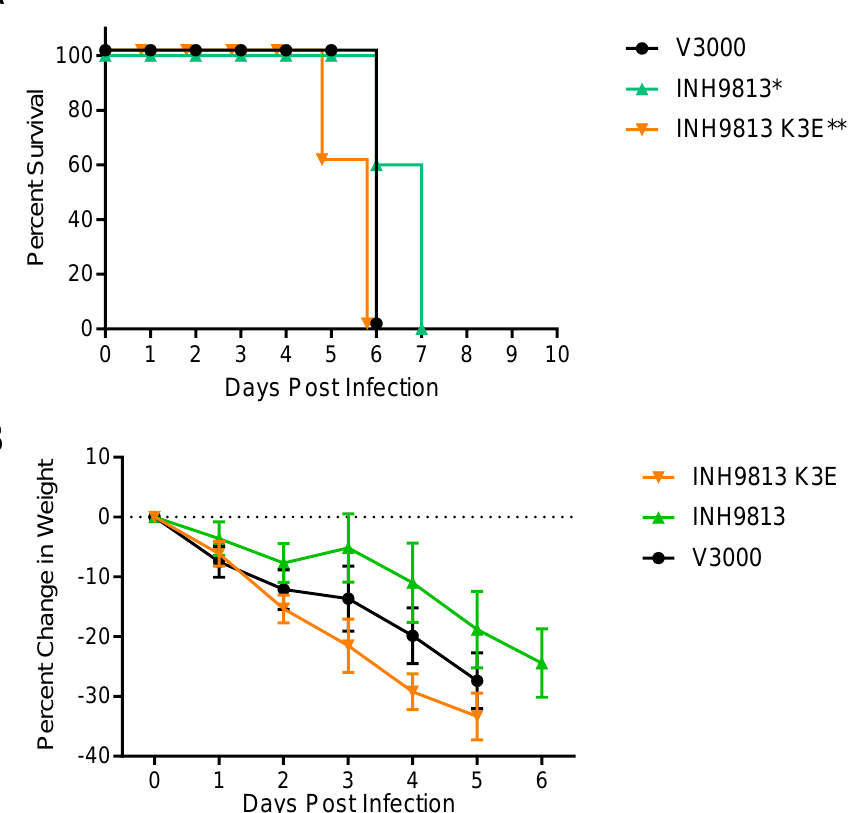
Figure 6. Survival curves ( A ) and weight loss ( B ) for 4–week–old CD–1 mice infected subcutaneously with 1000 PFU of each indicated virus. Experiments included 5 or 10 animals per group and were performed at least twice with similar results. Error bars are standard deviations. * = Survival V3000 vs. INH9813 p < 0.001, ** = Survival INH9813 vs. INH9813 K3E p < 0.001. With EEEV, sc. infection survival times for EEEV V105 and FL93–939 were not signifi- cantly different ( p > 0.916) (Figure 8A). However, V105 infections in this experiment series did yield one survivor (Figure 8A), which is also occasionally seen with FL93–939. Aerosol LD 50 values were also not significantly higher for FL93–939 vs. V105 ( p > 0.05) (Figure 9), although calculated values were lower for V105. With WEEV, we compared the McMillan clone with either Fleming or this virus with lysine changed to glutamic acid at E2 84 or this mutation and valine changed to methionine at E2 83 (K84D, V83M) (Figure 10). After sc. infection, McMillan and Fleming survival times were not significantly different ( p > 0.436) and neither virus was significantly different from the single glutamic acid 84 mutant (K84D, p = 0.306 and p = 0.369,